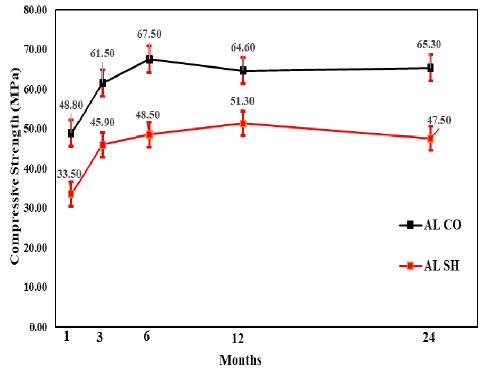
Figure 14. Aluminate (AL) accelerator mix compressive strength by age.